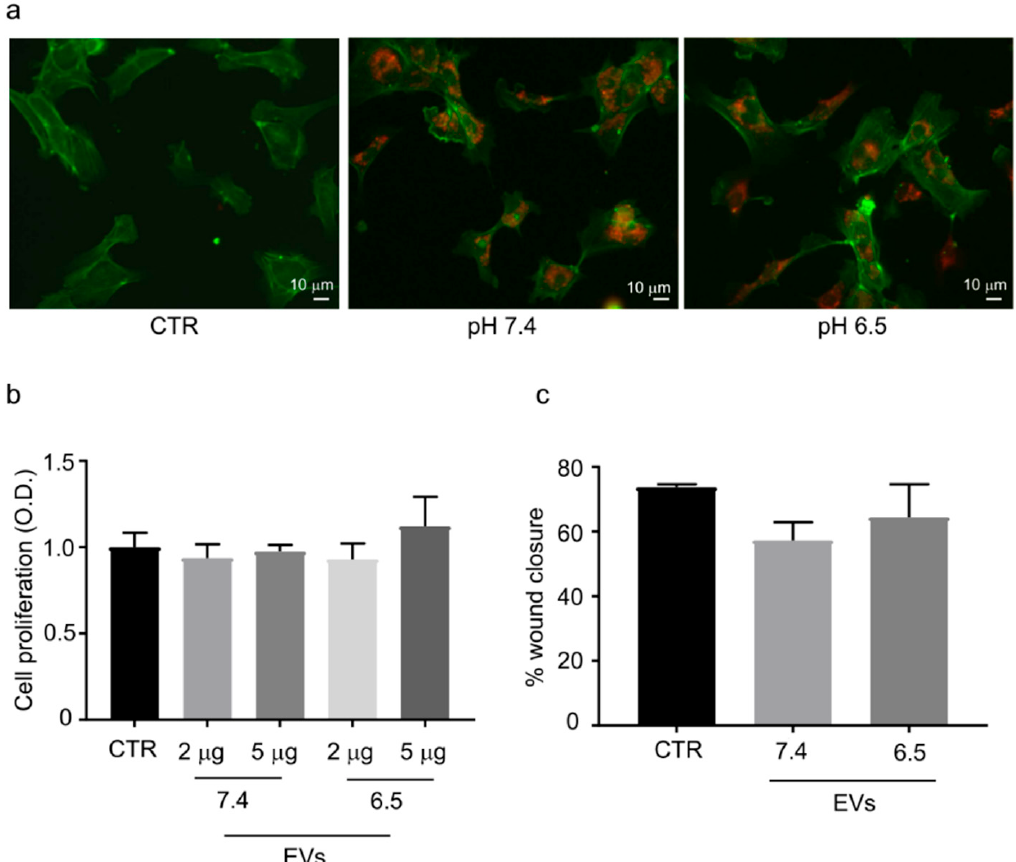
Figure 2. OS-derived EVs were uptaken by endothelial cells, and they did not a ff ect cell viability and migration. ( a ) The uptake of the fluorescently labelled (red) was evident in HUVEC cells after 24 h of incubation. No stain was revealed in the PBS negative control condition (CTR). Actin filaments were stained with a FITC-conjugated phalloidin (green). Representative images. Scale bar = 10 µ m (20 × objective; 200 magnification). ( b ) HUVEC cells viability was not a ff ected by EVs treatment. ( c ) HUVEC cells migration was not a ff ected by the treatment with OS–derived EVs. Graphs represent triplicate biological repeats and are displayed as mean ± SD, Mann–Whitney test, CTR: HUVEC cells not treated with